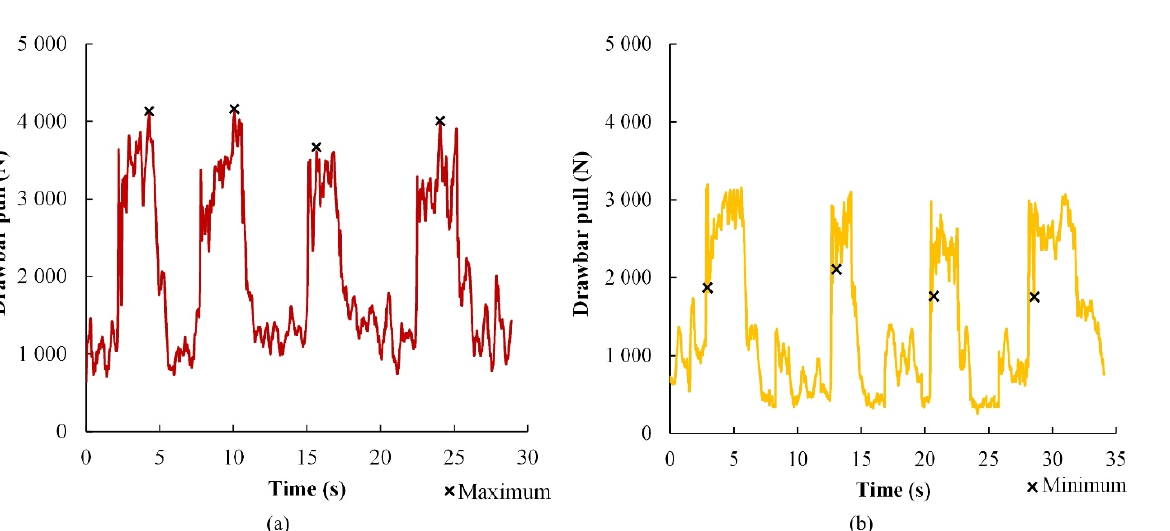
Figure 6. Characteristics of a fatigue analysis: ( a ) zero-based loading and ( b ) mean stress correction theory (Goodman, Soderberg, and Gerber).